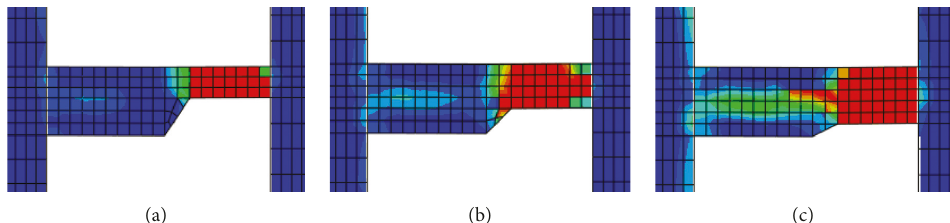
Figure 25: Compressive damage contour of the concrete of the SCB corresponding to different sectional heights. (a) 275/125. (b) 275/175. (c) 275/225.